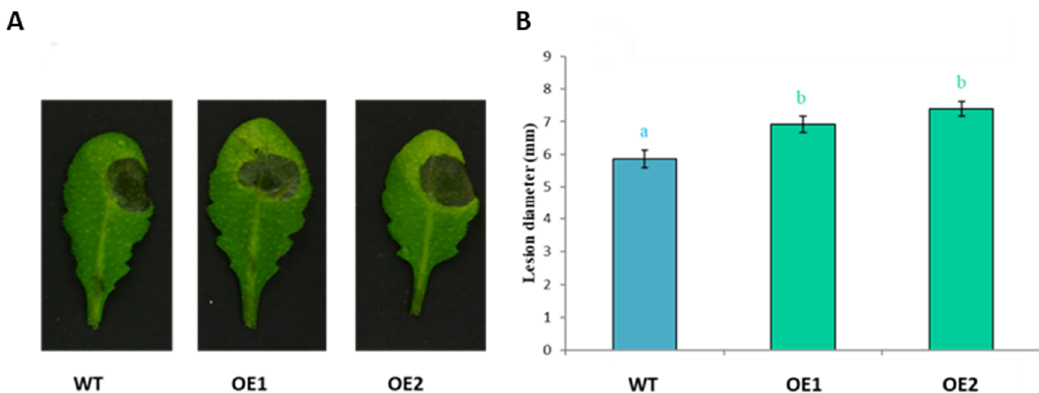
Figure 13. Overexpression of At3g59930 increased susceptibility to B. cinerea. Overexpression lines of At3g59930 were compared with wild type plants. Plants were grown in short day with 16 h dark and 8 h light at 24 °C for 4 weeks. Leaves were infected with 5 μL drop of B. cinerea spores. For each line, 4–5 plants were infected per replicate. ( A ). Representative pictures were taken at 3 dpi. ( B ). Lesion diameter in mm at 3 dpi. Mean data from three experimental replications were subjected to analysis of variance and differences among mean determined by LSD at a 5% significance level and n = 20. The values are means ± SE. different letters “a” and “b” indicate significant difference. WT, wild type; OE; overexpression line.